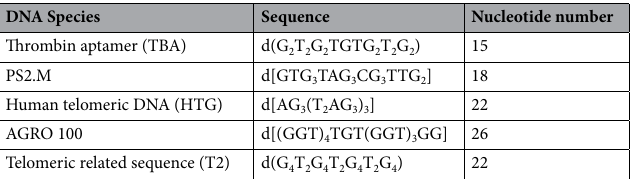
Table 1. Types of guanine-rich quadruplex structures (G-QDs) investigated in this